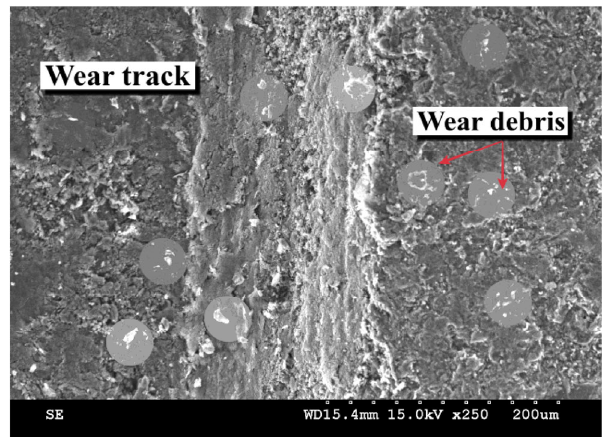
Fig. 13 SEM micrograph of sample CpC5 showing significant material